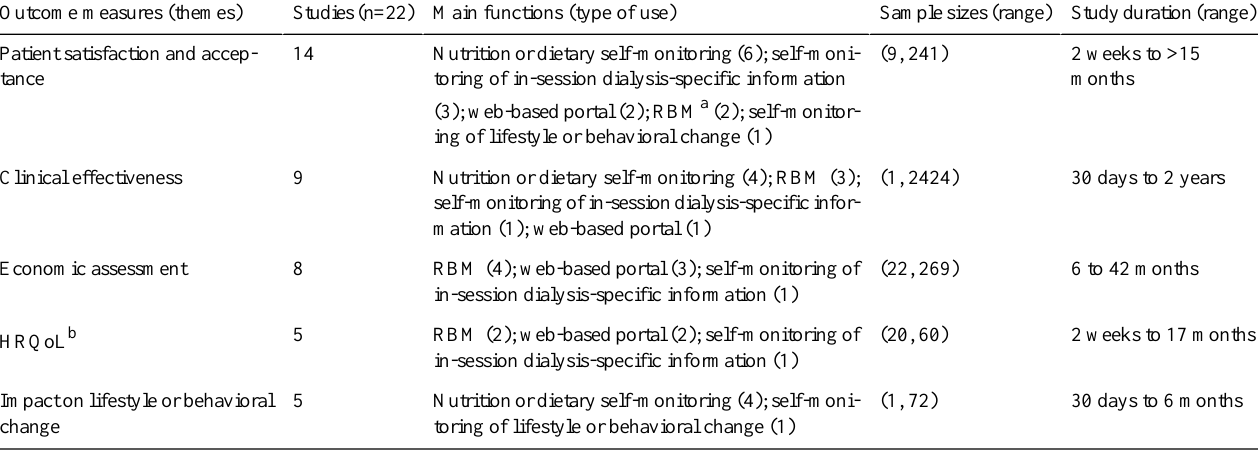
Table 2. Outcome evaluation of current mobile health